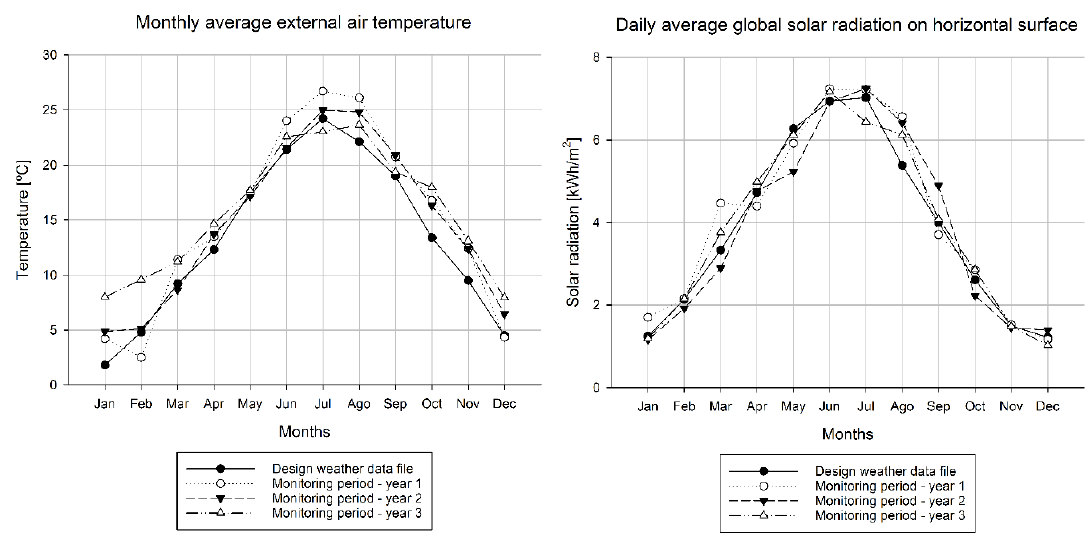
Figure 1. Weather data used in the study